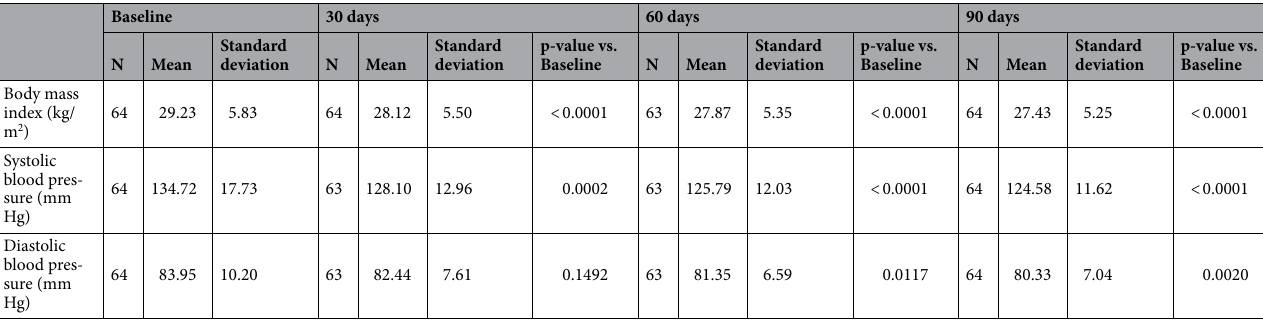
Table 2. Anthropometric and metabolic metrics at baseline and the first 3 months.